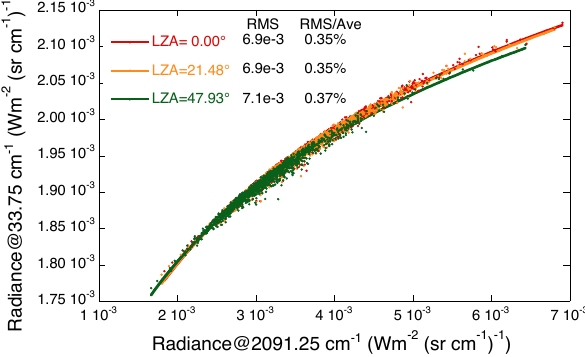
Figure 2. Relationship of radiance at 33.75 and 2091.25cm − 1 sim- ulated by LBLRTM from Phillips Soundings, where the scatter points and fitting curve are based on data for local zenith angles (LZA) of 0 ◦ (red), 21.48 ◦ (orange) and 47.93 ◦ (green). Units are Wm − 2 sr − 1 (cm − 1 ) − 1 .